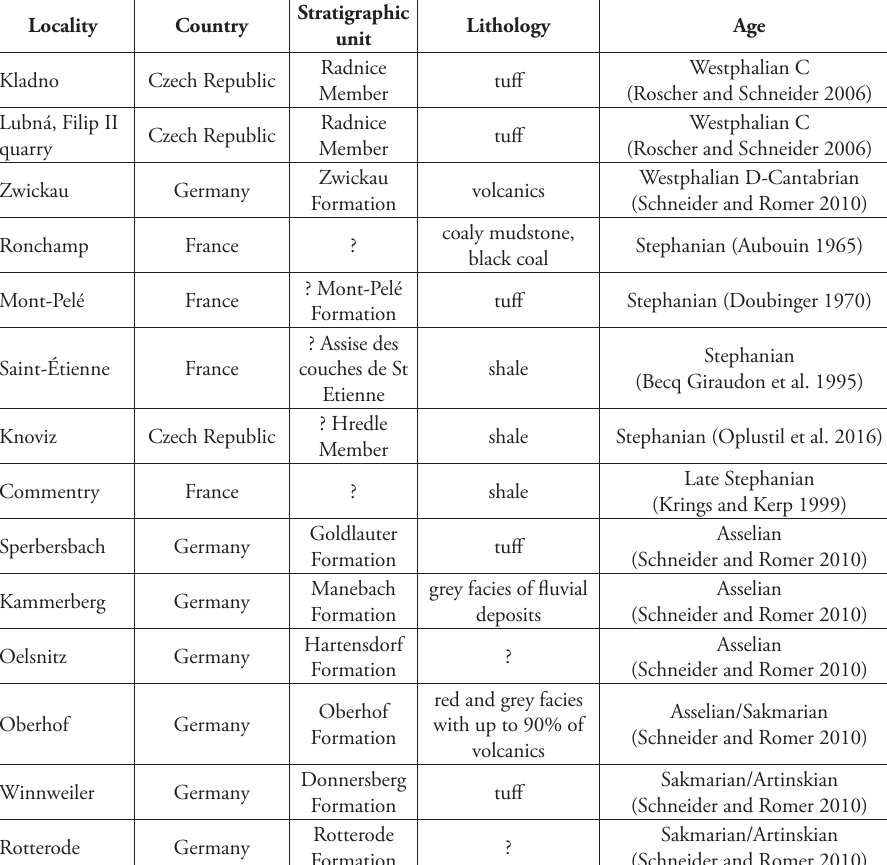
Table 1. Stratigraphy, age and lithology of the different localities. Locality